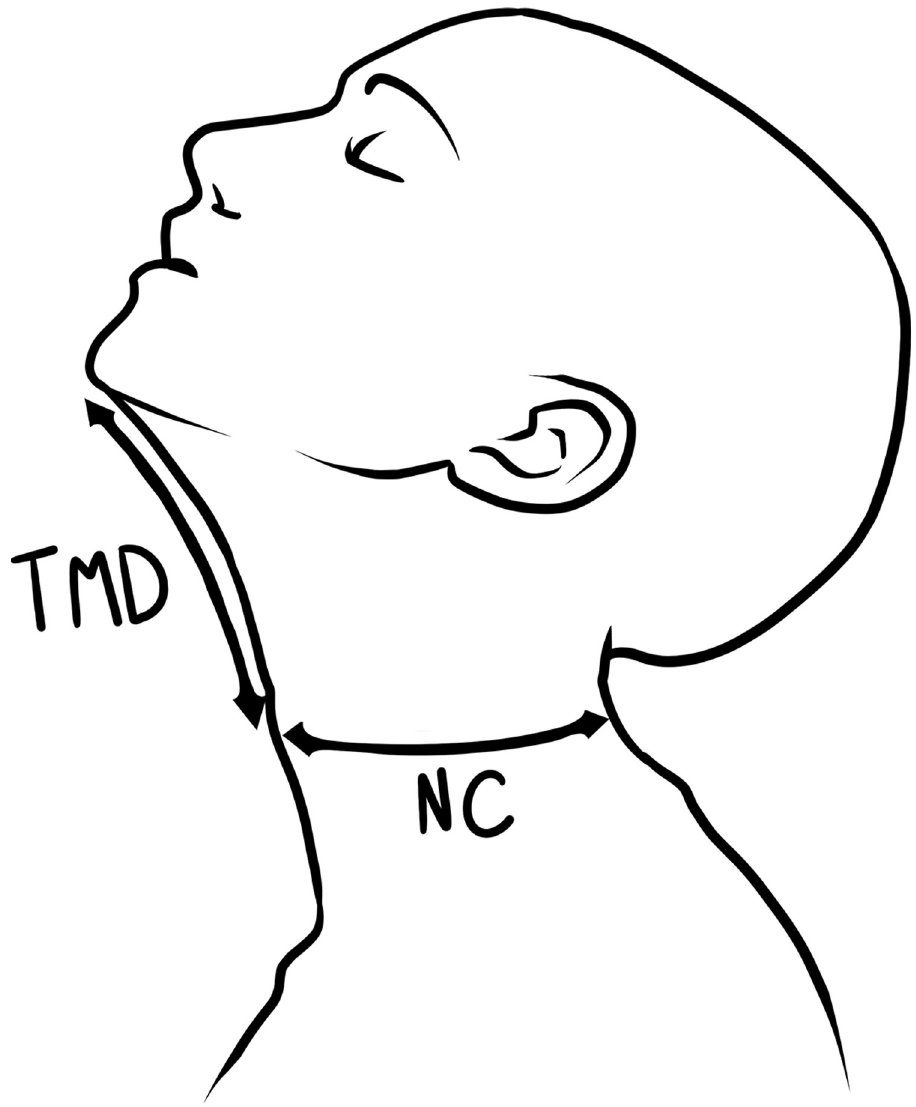
Fig 1. NC measurement and TMD measurement: NC measurement and TMD measurement. apparent on chest x-ray (radiograph) (CXR), mediastinal goiter (Fig 2), histology and history of DTI were measured as possible predictors of DTI. The analysis included dichotomization and stratification of continuous and non-continuous variables into “risk” categories: BMI ( < 30 kg/m2, � 30 kg/m2) [10]; inability to prognath (yes/no); head movement ( � 90˚, > 90˚); mouth opening ( < 4 cm, � 4 cm); Mallampati score: < III, � III; NC ( < 40 cm, � 40 cm) [11]; TMD ( � 6.5 cm; > 6.5 cm); NC/TMD ( < 5; � 5) [8]; tracheal deviation at CXR (yes/no); medi- astinal goiter (yes/no) histology (benign/malignant); history of DTI (yes/no) [12]. DTI was defined as maneuver performed with a correct head position and external laryn- geal manipulation resulting in: a) difficult laryngoscopy (Cormack-Lehane grade III or IV); b) more than one intubation attempt; c) needing of no standard devices and/ or procedures; d) withdrawal and procedure re-planning [9].